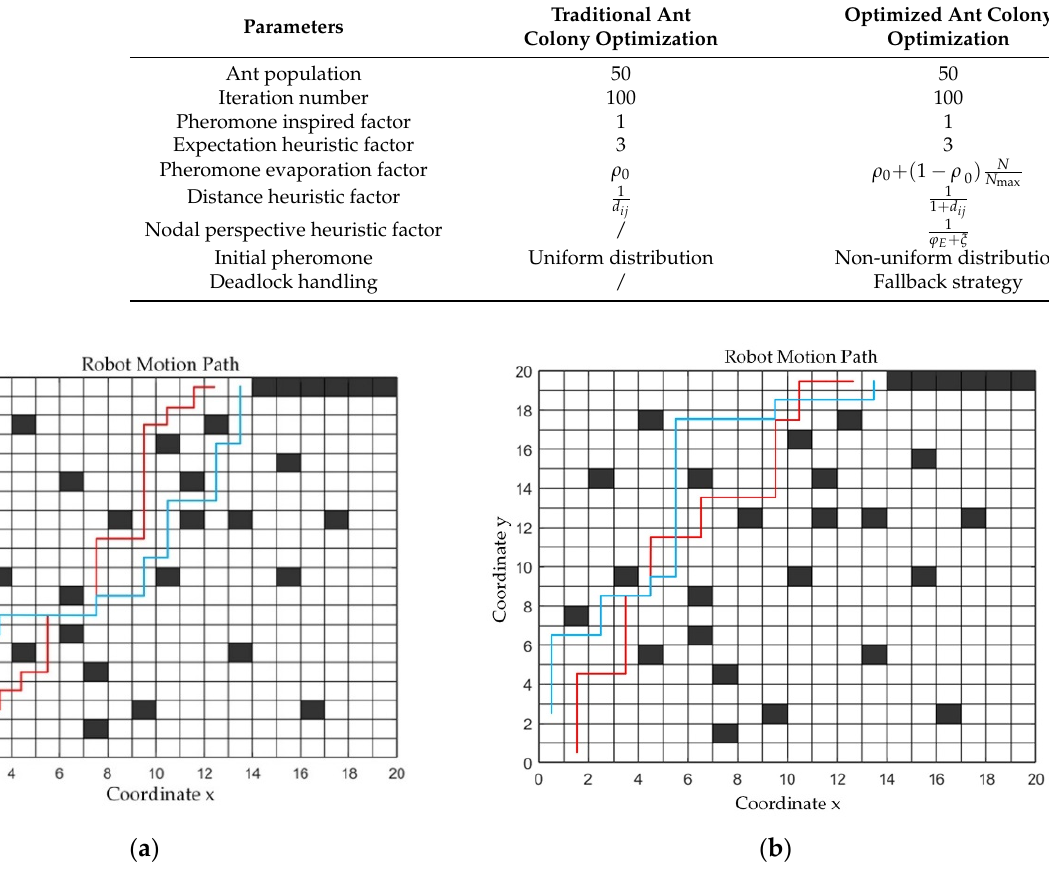
Figure 11. Schematic diagram of the ant colony algorithm robot movement path (Environment 1). ( a ) Ant colony algorithm ( b ) Improved ant colony algorithm.